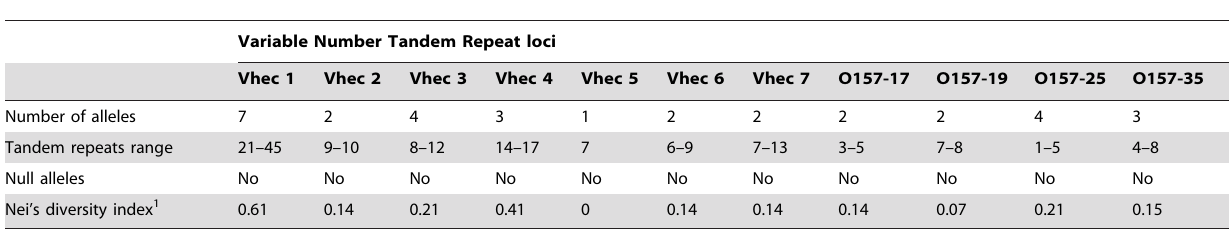
Table 4. Characterization of 11 variable-number tandem repeat loci in the O157:H7 STEC isolates used in this study.